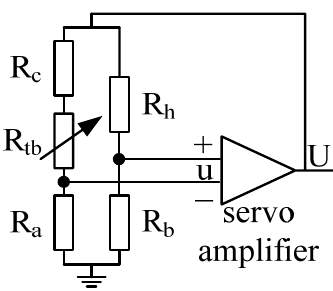
Figure 3. Scheme of a CTD mode driving circuit.